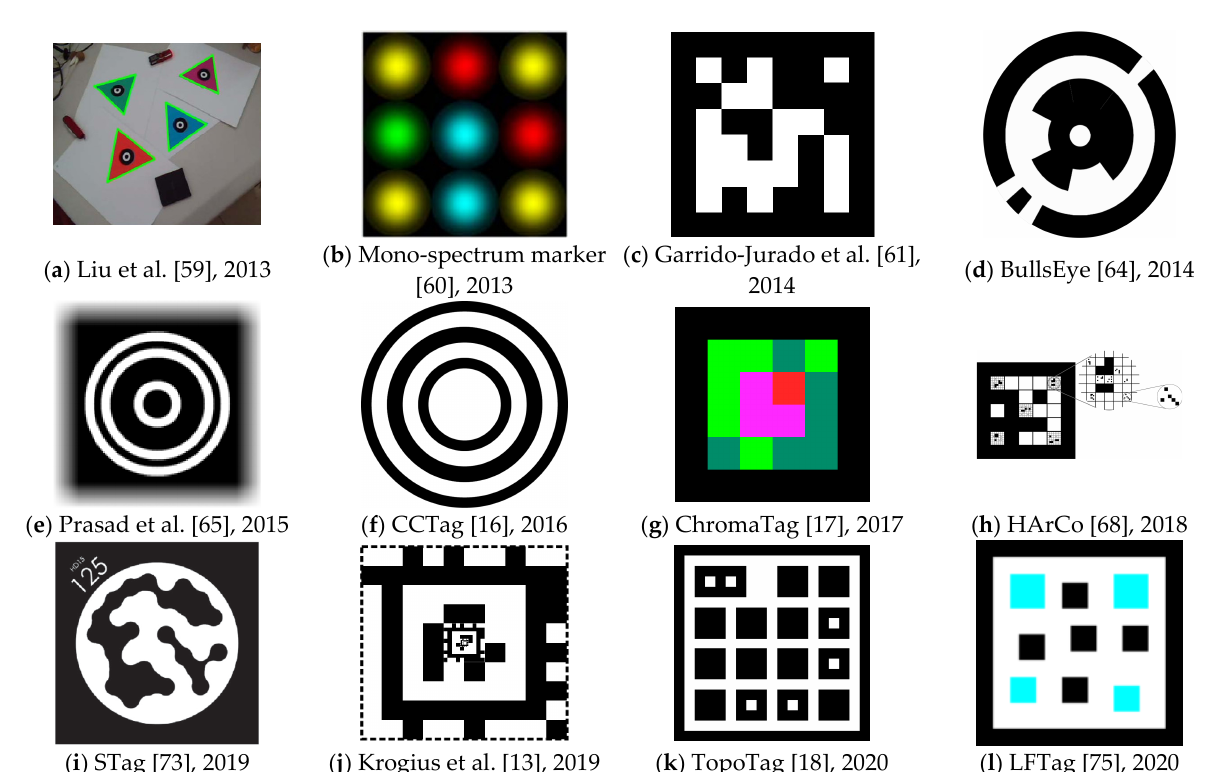
Figure 2. Examples of the most notable marker systems with their name (if available) and year of their publication.